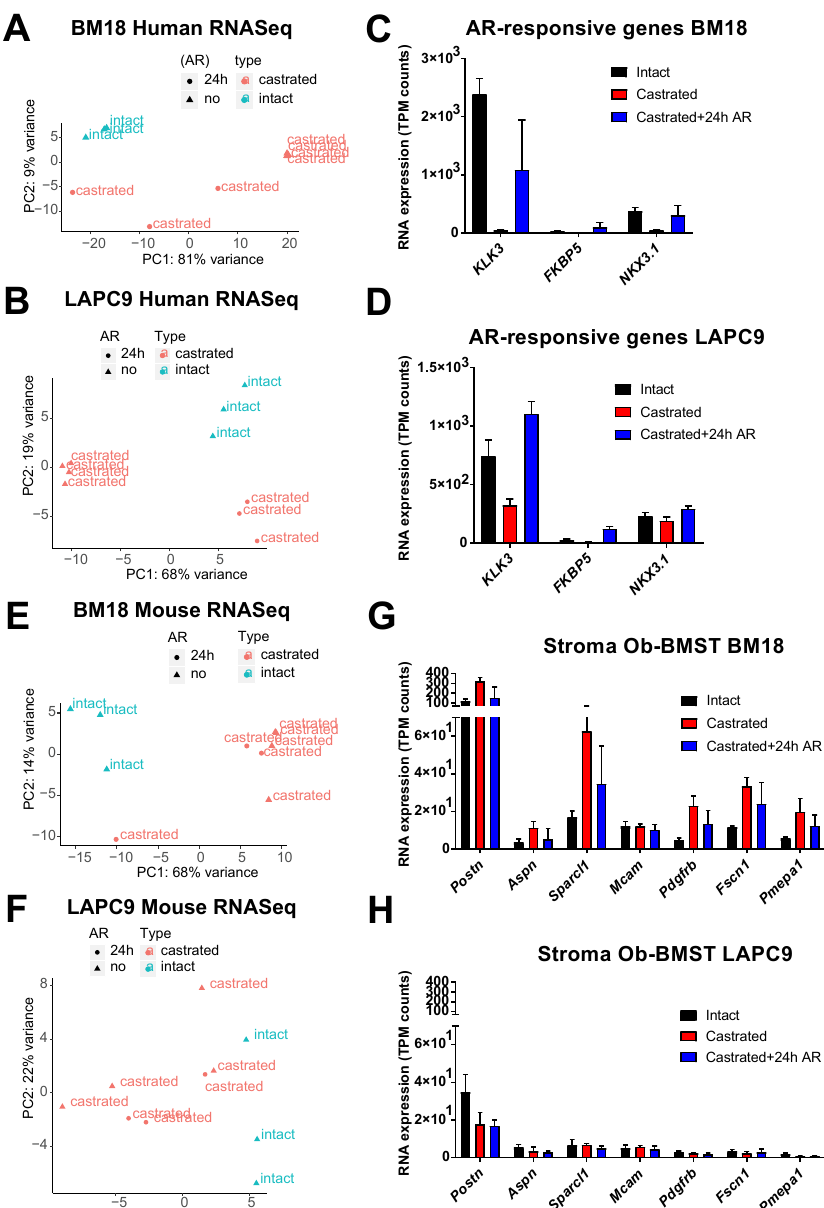
Figure 2. Separation of human (tumor) and mouse (stroma) transcriptomes of BM18 and LAPC9 tumors. ( A , B ) Principal component analysis plot of the gene expression of the 500 most variable genes on all samples; BM18 human transcripts ( A ) and LAPC9 human ( B ) at intact, castrated and replaced (castrated + 24 h AR) conditions. ( C , D ) Expression values of AR direct target genes as detected by RNA-Seq (transcript per million (TPM) counts) in the BM18 ( C ) or LAPC9 ( D ) tumors as confirmation of the e ff ective repression of AR downstream signaling by castration. Intact ( n = 3), castrated ( n = 4) and replaced ( n = 3). ( E,F ) Principal component analysis plot of the gene expression of the 500 most variable genes on all samples, BM18 mouse ( E ) and LAPC9 mouse ( F ) at intact, castrated and replaced (castrated + 24 h AR) conditions. ( G , H ) Expression values of the prostate-specific bone metastasis signature (Ob-BMST) seven upregulated stroma signature genes, as detected by RNA-Seq (TPM normalized counts) in the mouse transcriptome of BM18 ( E ) or LAPC9 ( F )